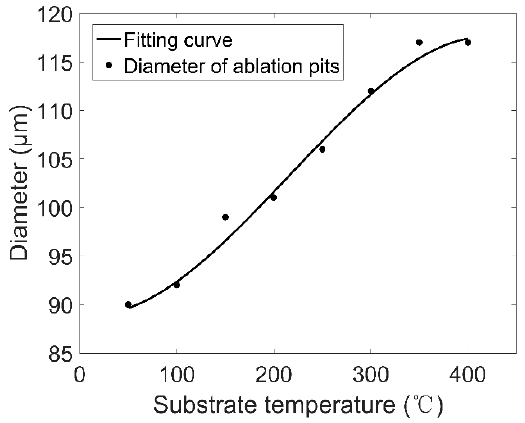
Figure 12. Diameter of ablation craters under different substrate temperature.